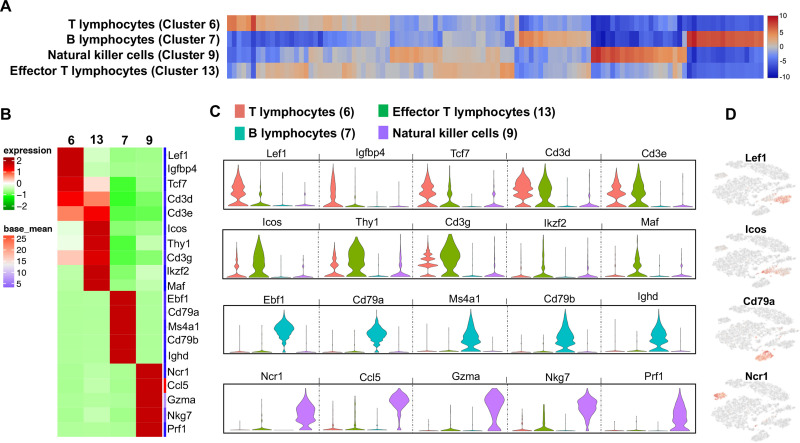
Four discrete lymphocyte populations suggest heterogeneity among treatment groups.(A) Heatmap shows the top 120/N upregulated genes for 5 distinct lymphocyte clusters ranked by log2 fold-change, where N = total number of clusters. (B) The top 5 genes with gene names of each lymphocyte cluster are shown in heatmap. (C) Violin plots show variability in transcript levels among cell populations including T lymphocytes (red, cluster 6), effector T lymphocytes (green, cluster 13), B lymphocytes (teal, cluster 7) and natural killer cells (lavender, cluster 9). The y-axis indicates normalized expression value, log2 (average UMI count + 1). (D) Representative genes from each cluster show their distribution in t-SNE plot.